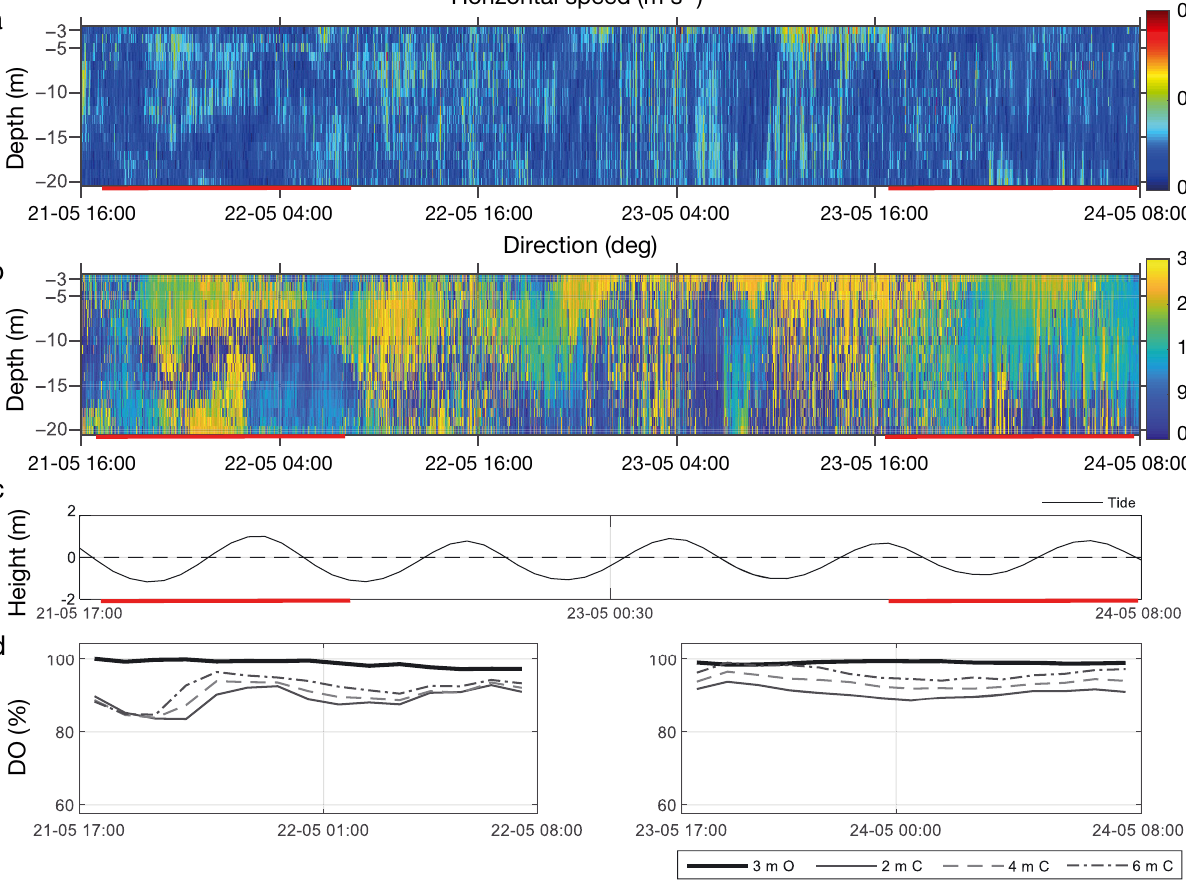
Fig. 2. (a) Current speed and (b) direction at Soløya in the top 20 m of the water column, measured by the Doppler current pro- filer (DCP) in position B (see Fig. 1) from 21 to 24 May 2019. The red horizontal line along the x -axis indicates the periods where DO measurements were taken. (c) Expected tidal height (thin black line). (d) Hourly median DO for all sensors at Soløya, for the periods marked with red in the graphs above. O: outside; C: centre of the